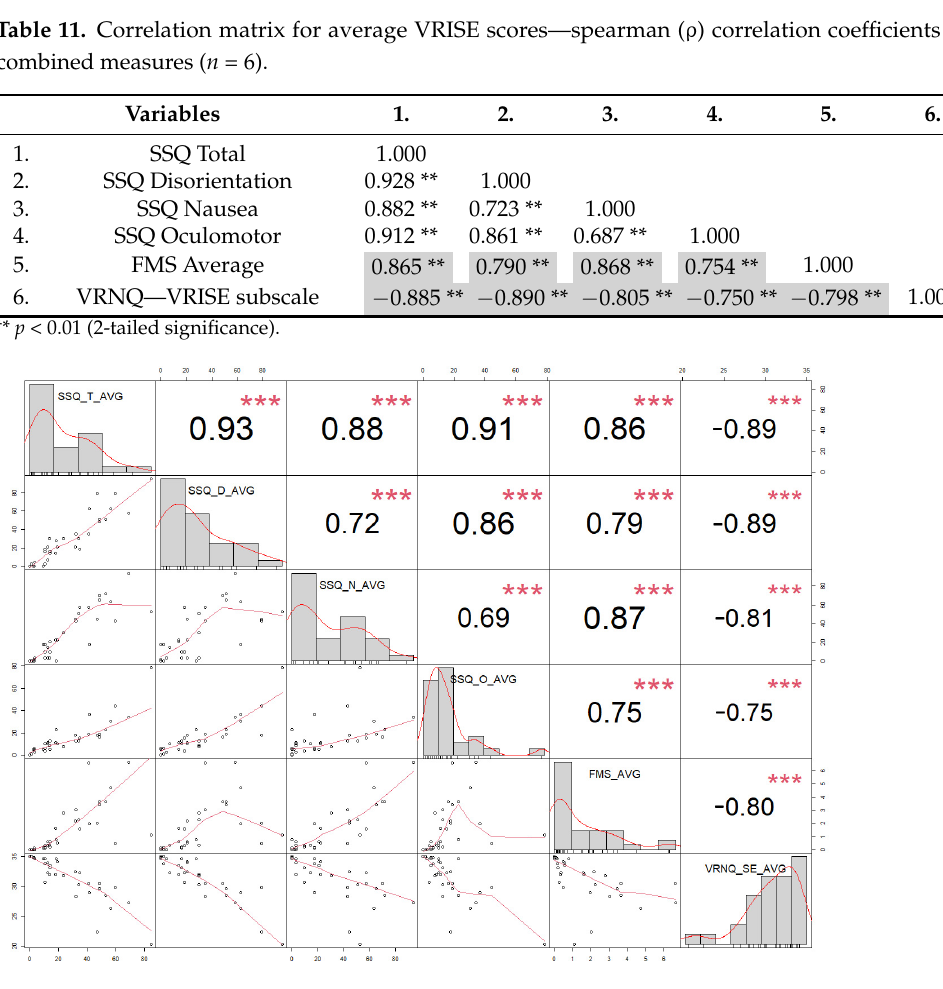
Figure 4. Correlation chart matrix for average VRISE scores—spearman ( ρ ) correlation coefficients for combined VRISE measures ( n = 6). There are also bivariate scatterplots on the matrix, with a fitted line and histogram for each variable. * p < 0.05, ** p < 0.01, *** p <